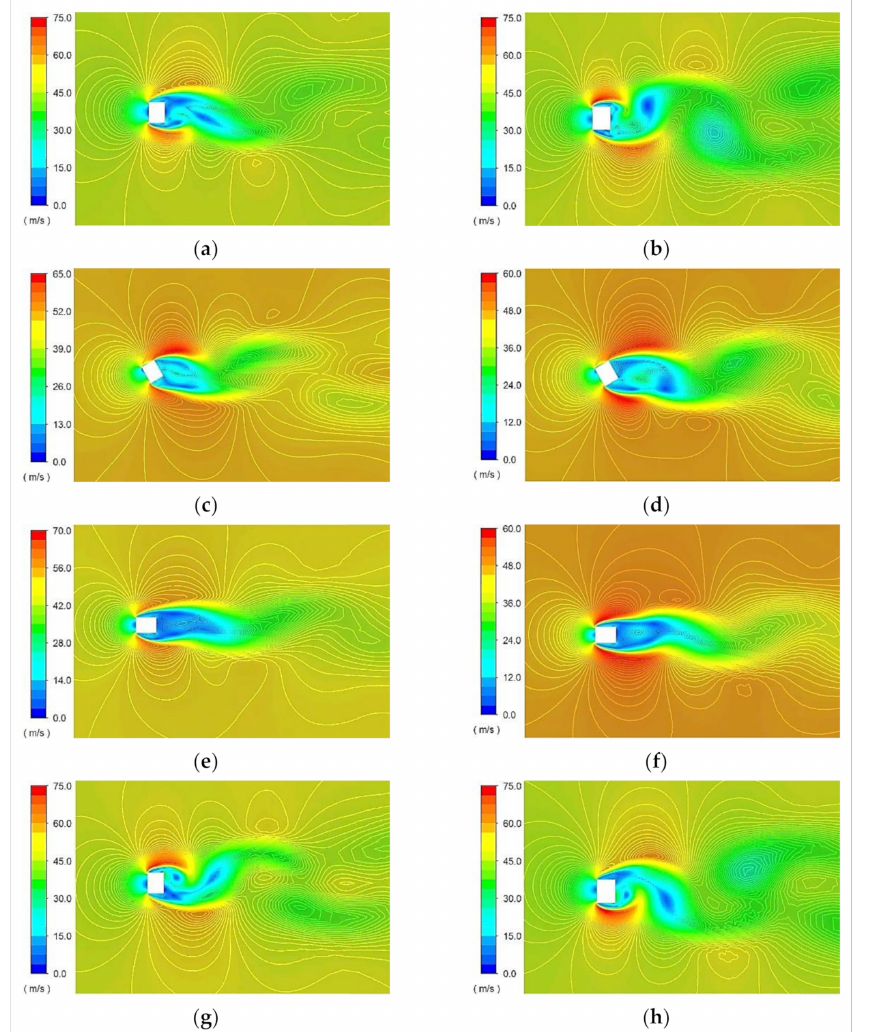
Figure 9. Velocity magnitude in the XZ plane at Y = 100 m. ( a ) Case 1. The target model, θ = 0 ◦ ; ( b ) Case 2. The reference model, θ = 0 ◦ ; ( c ) Case 3. The target model, θ = 30 ◦ ; ( d ) Case 4. The reference model, θ = 30 ◦ ; ( e ) Case 5. The target model, θ = 90 ◦ ; ( f ) Case 6. The reference model, θ = 90 ◦ ; ( g ) Case 7. The target model, θ = 180 ◦ ; ( h ) Case 8. The target model, θ = 180 ◦